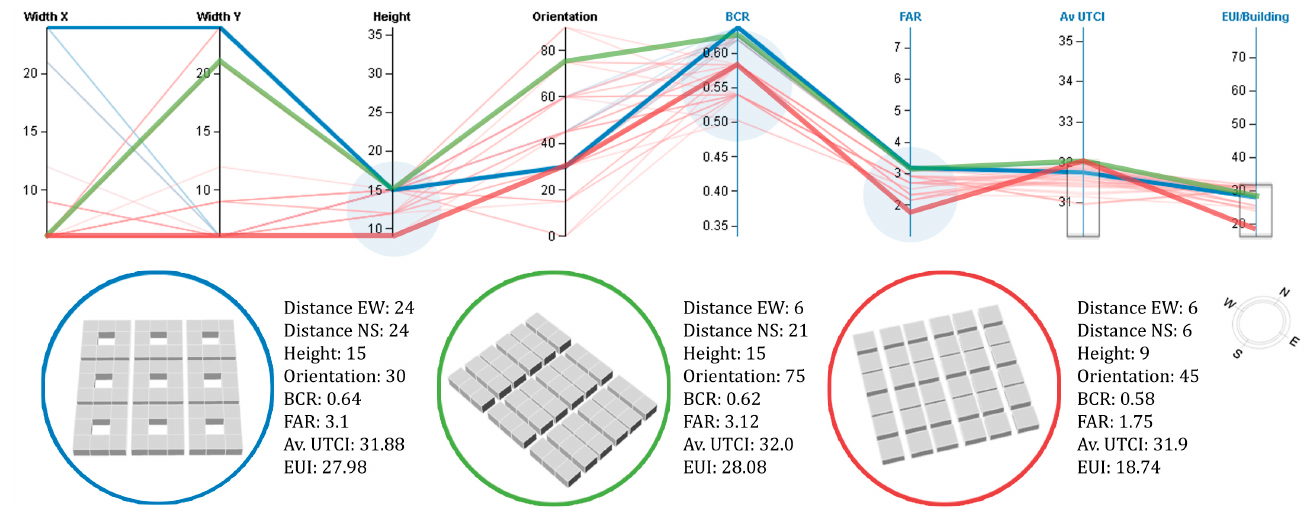
Figure 12. Selective cases for moderate heat stress Av.UTCI and the lowest 40% EUI.